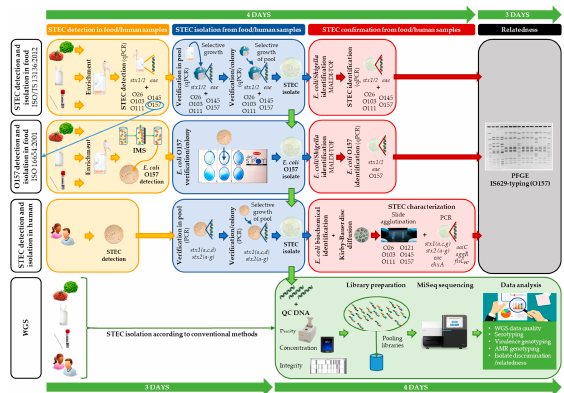
Figure 1. A schematic overview comparing the conventional methods and whole genome sequencing (WGS) workflow as applied in outbreak investigation. The routinely applied conventional methods for food samples (according to ISO / TS 13136:2012 (for detection and isolation of Shiga toxin-producing Escherichia coli (STEC)) and ISO 16654:2001 (for detection and isolation of Escherichia coli O157)) and for human samples are depicted. Shortly, according to ISO / TS 13136:2012, screening for STEC is performed through qPCR detection of stx1 , stx2, and eae in enriched food or swab samples. In case of stx and eae detection, serogroup (i.e., O-type) determination is also performed with qPCR. STEC isolation is attempted through selective growth on CHROMagar STEC. Both qPCR assays are repeated on a sweep of colonies (pool) for STEC detection, and subsequently on separate colonies to enable STEC isolation. Identification of E. coli / Shigella is performed with MALDI-TOF mass spectrometry (MS), and the qPCRs are repeated for STEC identification and confirmation. When a STEC O157 is detected with the ISO / TS 13136:2012 workflow (through qPCR; depicted with a blue arrow), isolation can also be attempted through the serogroup specific workflow (ISO 16654:2001), as was performed for the food isolates of the outbreaks analyzed in this study. Shortly, according to ISO 16654, E. coli O157 in enriched food or swab samples are captured using immunomagnetic beads (i.e., immunomagnetic separation (IMS)), and selectively grown on a CT-SMAC plate for E. coli O157 detection. Through the Oxoid-Latex test, E. coli O157 identification is performed on single colonies, to enable their isolation. The isolated E. coli O157 is then confirmed for E. coli through MALDI-TOF MS, and for STEC O157 through PCR detection of stx1, stx2, eae, and O157 (e.g., rfbE ). Human samples are selectively grown on (CT)-SMAC biplates for STEC detection. A sweep of colonies (pool) is tested for stx presence (including subtyping). STEC is verified through PCR on single colonies grown ((CT)-SMAC) from the PCR positive pool. Isolated STEC is then confirmed as E. coli through biochemical identification tests (citrate, mobility indole urease, indole, urease, β -glucuronidase, and sorbitol). Moreover, all human isolates are phenotypically tested for antimicrobial resistance (AMR) through disc di ff usion. STEC characterization is further performed through PCR detection of multiple virulence genes, and serogroup determination through slide agglutination. IS629-typing and pulsed-field gel electrophoresis (PFGE) are performed to investigate the relationship between human and food isolates. Completion of these conventional workflows takes approximately 7 working days (indicated by the green time line). With WGS, STEC isolation (according to the conventional methods) is followed by DNA extraction, DNA quality control, and subsequent Nextera XT library preparation for MiSeq sequencing. From the obtained data, all isolate characteristics, and the relatedness between the isolates are retrieved with one approach, with a higher resolution (approximately 7 days (i.e., five working days as two days are used for sequencing), indicated by the green time line). More details concerning the applied workflows are available in the Materials and Methods section and the Supplementary